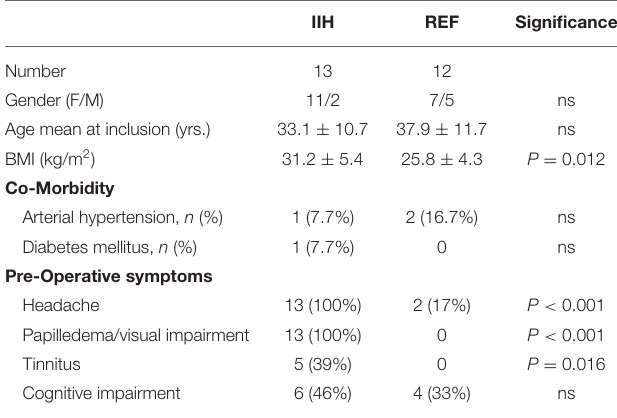
TABLE 2 | Material of patients with definite IIH and REF subjects. IIH REF